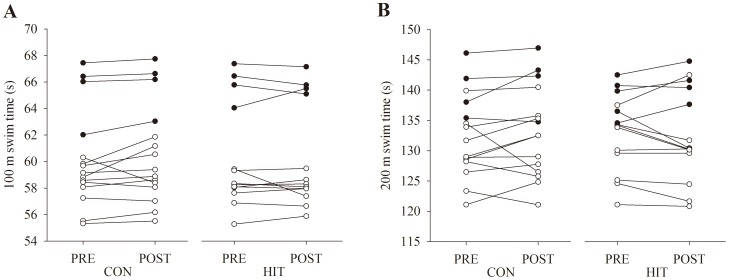
Swimming performance.Performance of 100-out, starting with wall push-off and one swimmer in the pool at a time (A) and 200 m freestyle in a competition setting, starting from blocks in heats of 3–4 swimmers (B) as determined before (PRE) and after (POST) a training intervention. One group performed usual swim-training (CON) and another group reduced their training volume by 50% and more than doubled the amount of high-intensity training (HIT). On average, both the 100 m and 200 m performance was similar before and after the 12 week intervention period in both groups. Individual data is presented. Open circles: male; Closed circles: female.